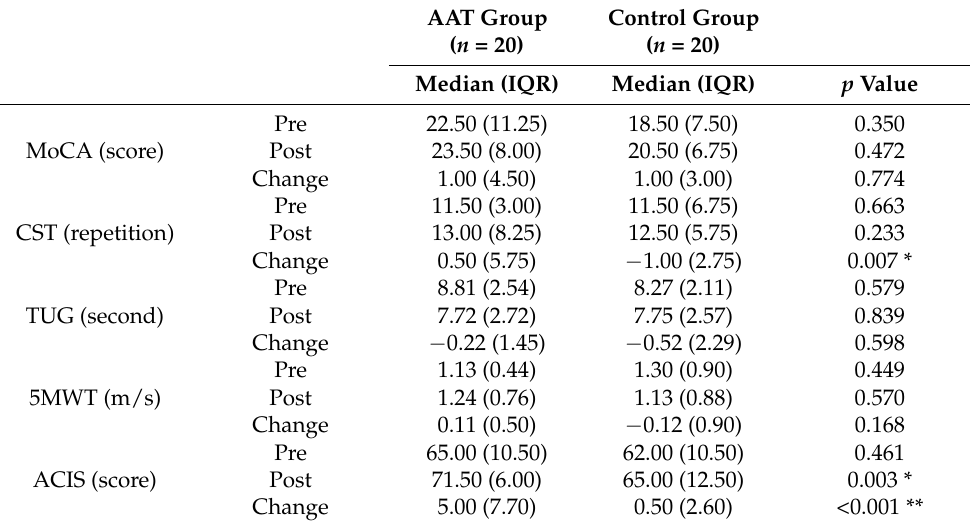
Table 2. Median and interquartile range of outcomes and changes in scores pretest and